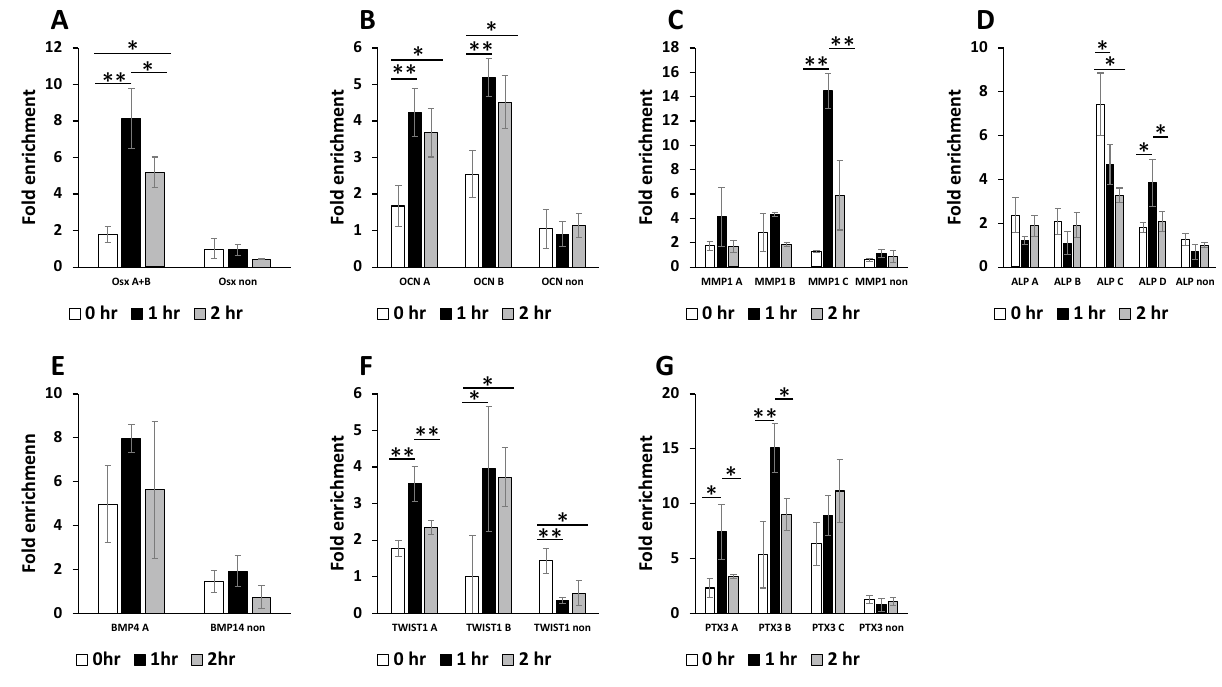
Figure 8. DPP-mediated NF-κB p65 activation directly associates with the odontogenic differentiation target gene promoter sequence containing NF-κB response elements in vivo. Sheared chromatin from DPSCs treated with or without DPP were used to perform ChIP assays. Cross-linked protein–DNA complexes were incubated with an anti-p65 antibody (closed bars) or control IgG antibody (open bars) on immunoprecipitated DNA was analyzed by qPCR using primers comprising the NF-κB sites on Osx, OCN, MMP-1, ALP, BMP4, TWIST1 and PTX3 promoters. Primer sequences are supplied in the supplementary section. The κB binding sites are designated from A–D in each of these promoters. A pair of random primers were used to demonstrate the specificity of binding. Results are expressed as percent of input DNA compared to IgG. Statistical significance are indicated as mean ± SD; *p < 0.05, **p <